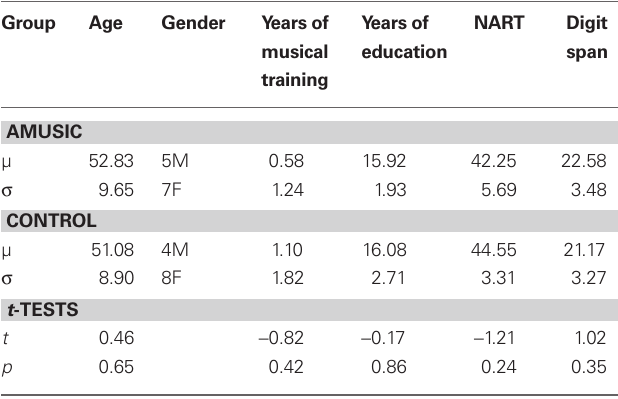
Table 1 | Amusic and control participant characteristics; summary of the two groups in terms of their mean age, gender, years of musical training, and education, NART and total digit span (forward and backward).